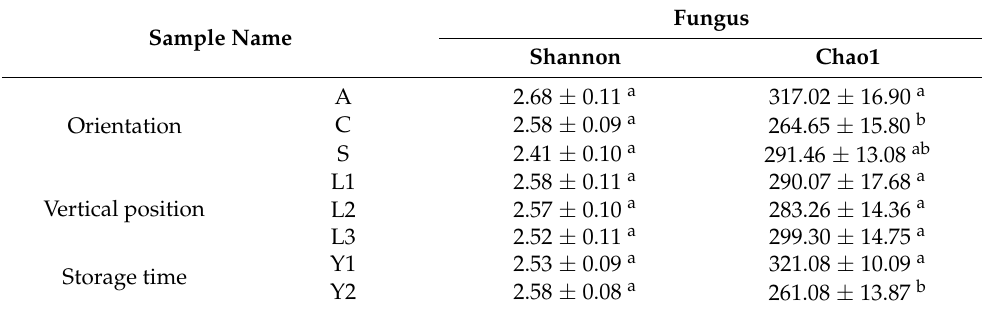
Table 1. Shannon’s diversity index and Chao1 richness index of fungi on the rice surface.